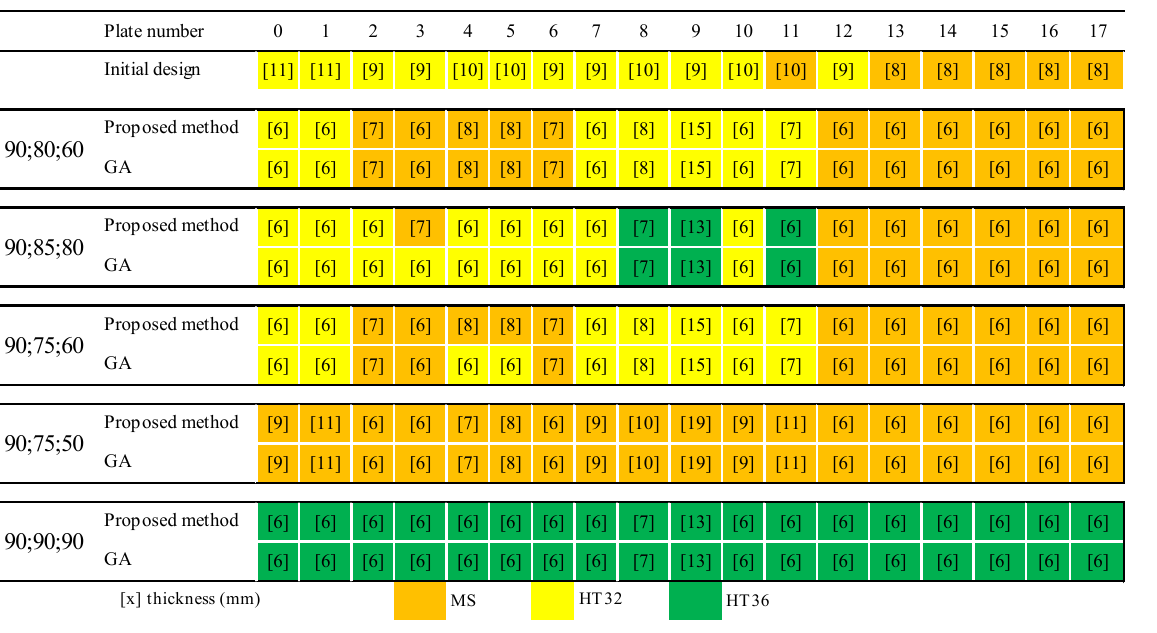
Figure 12. Plate material type and thickness distribution of 3rd model.